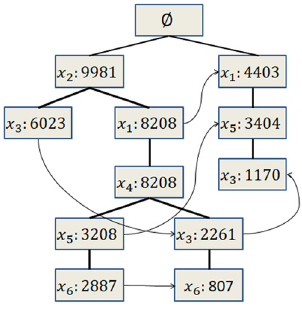
Figure 2. A sample FP-tree generated